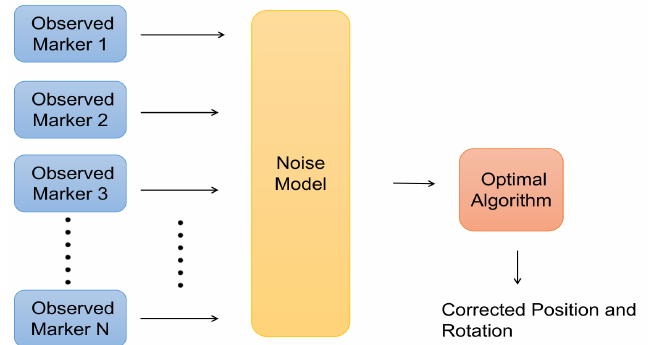
Figure 4. The flow chart of the